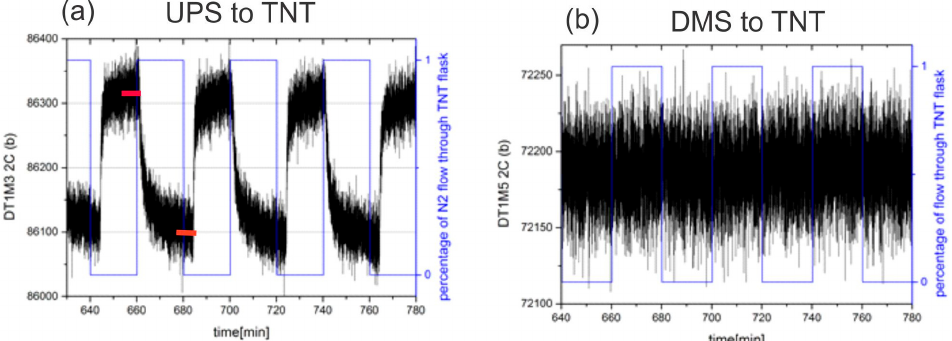
Figure 13. ( a ) Response of UPS sensor to switching between pure nitrogen and nitrogen with the maximal concentration of TNT vapour. The red lines indicate measurements that were averaged to determine the amplitude of response. ( b ) Response of DMS sensor to switching between pure nitrogen and nitrogen with the maximal concentration of TNT vapour.